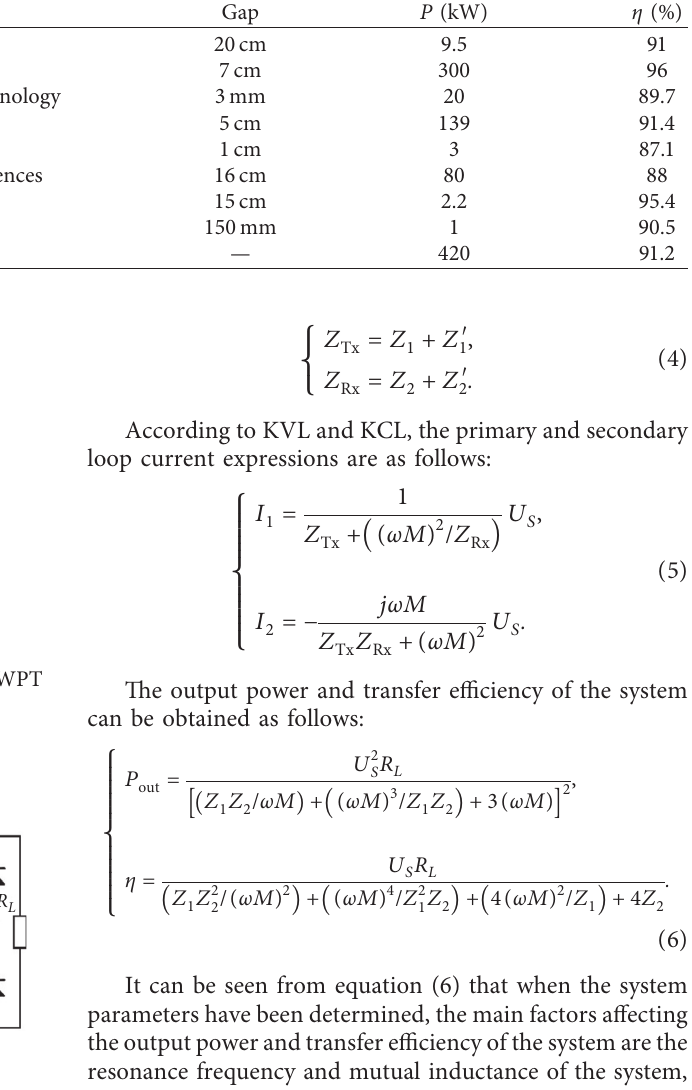
Figure 2: System circuit topology.